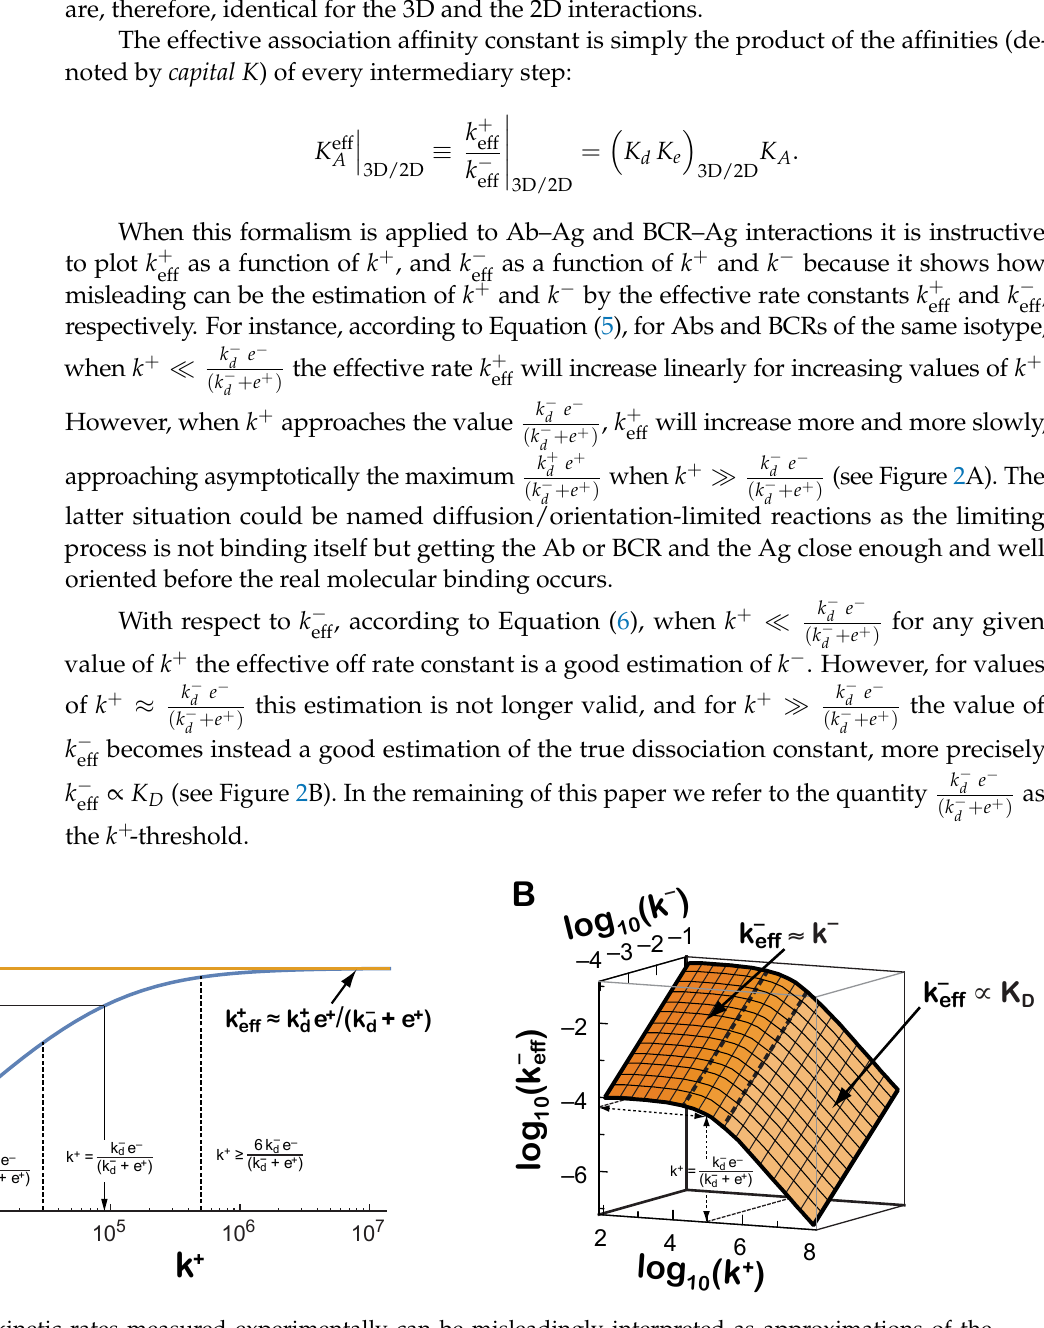
(panel A ) and k − (panel B ) as a function of eff eff = 10 6 M − 1 s − 1 , k − = 10 3 s − 1 , d d